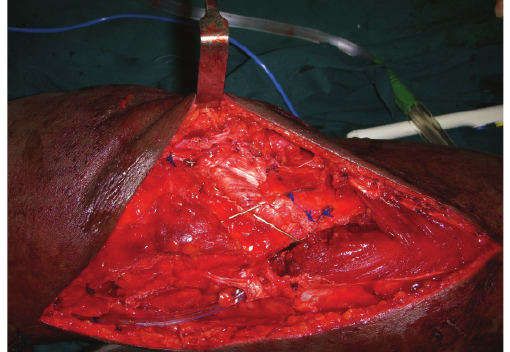
Figure 5: Patellar tendon repaired and protected with a figure of 8 wiring.